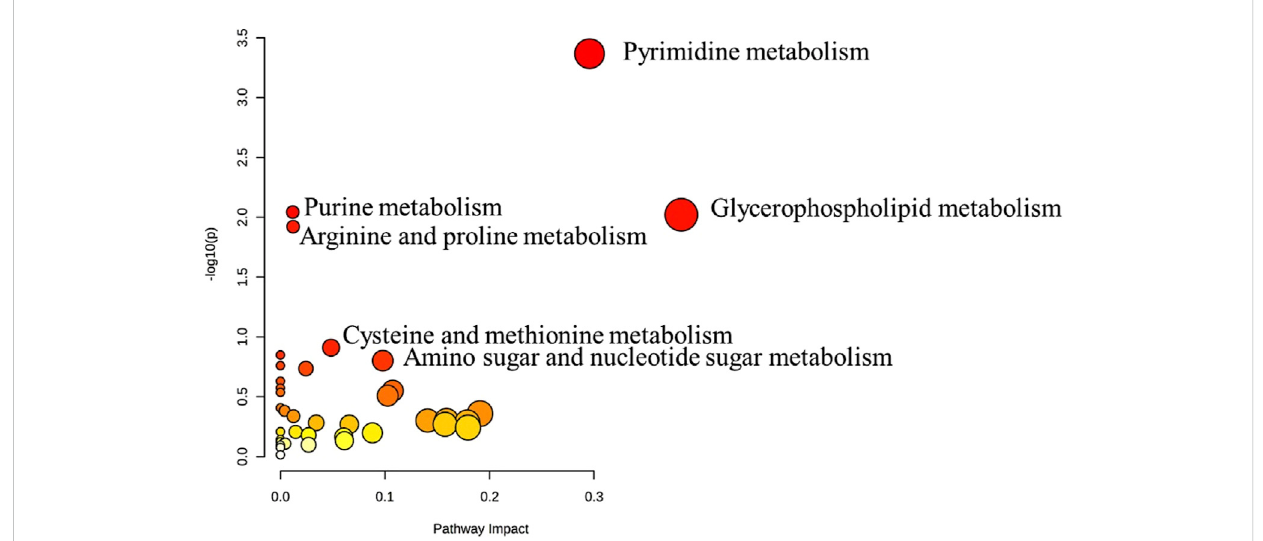
FIGURE 3 Pathway Analysis for the signi fi cant metabolites dysregulated between GAL patients and healthy control. Four hundred eighty metabolites were ultimatelyidenti fi edashumanendogenousmetabolites,where209and271wereupanddownregulated,respectively.Colors(varyingfromyellowtored) mean the metabolites are in the data with different signi fi cance levels ( p